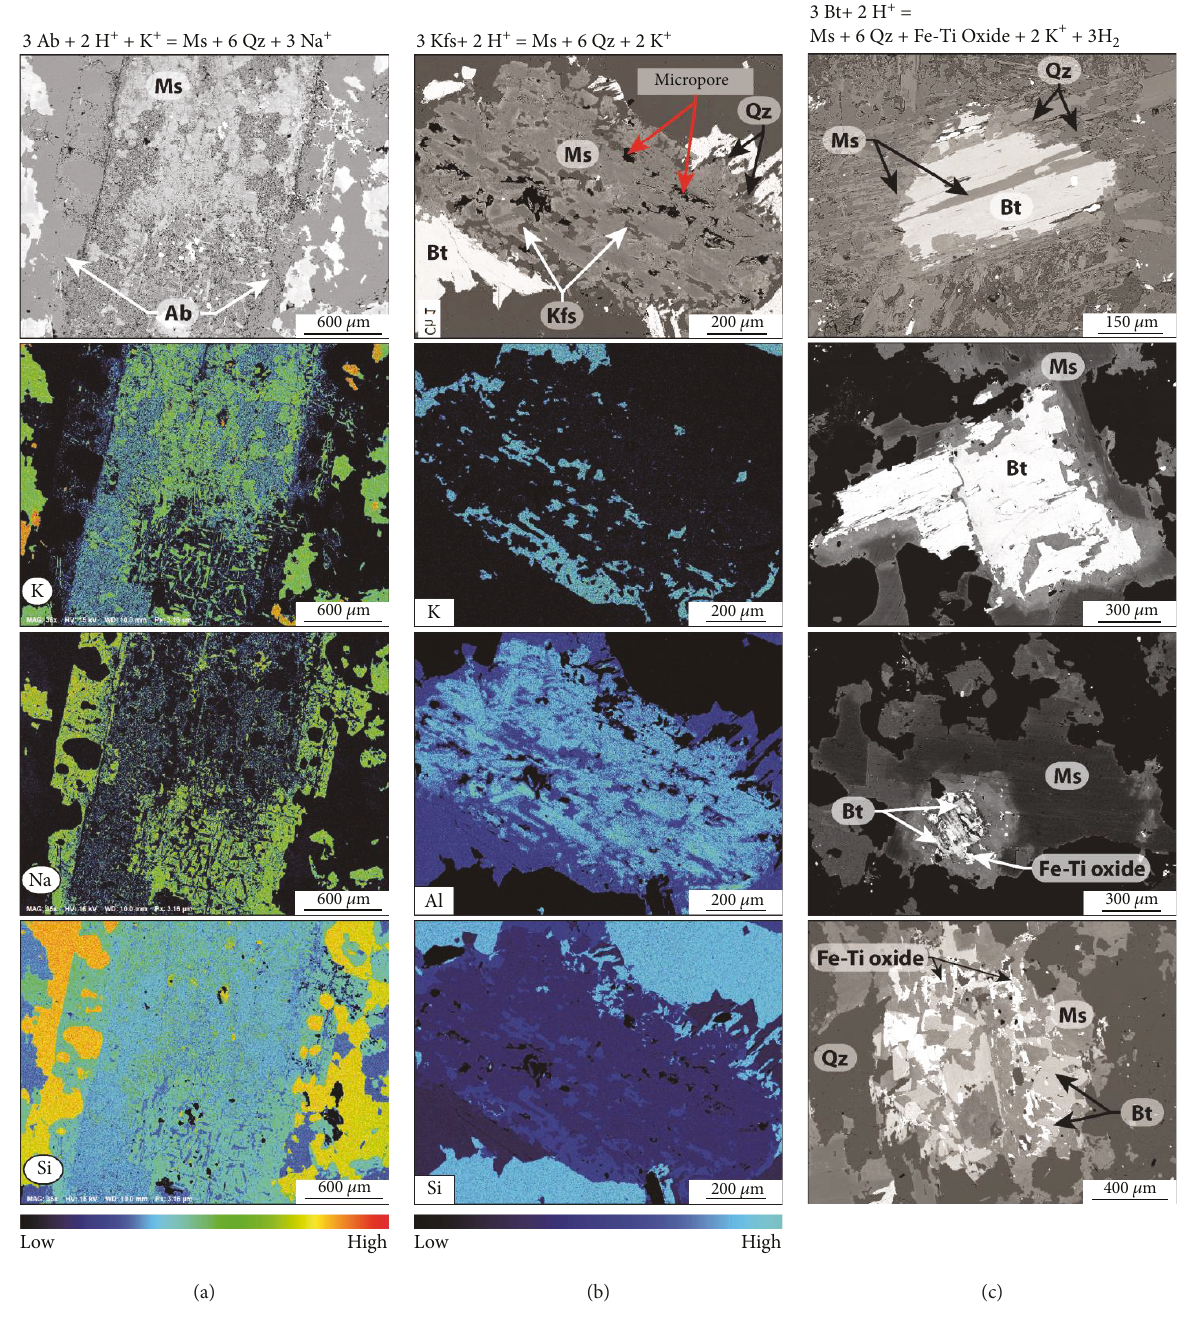
Figure 5: SEM microphotographs and element mapping of Na, K, and Al showing the replacement textures of (a) albite, (b) K-feldspar, and (c) biotite involved during the greisen alteration. Note the development of microporosity in the altered sections of K-feldspar and albite. Abbreviations from Whitney and Evans [45]. Ab: albite; Bt: biotite; Kfs: k-feldspar; Ms: muscovite; Qz: